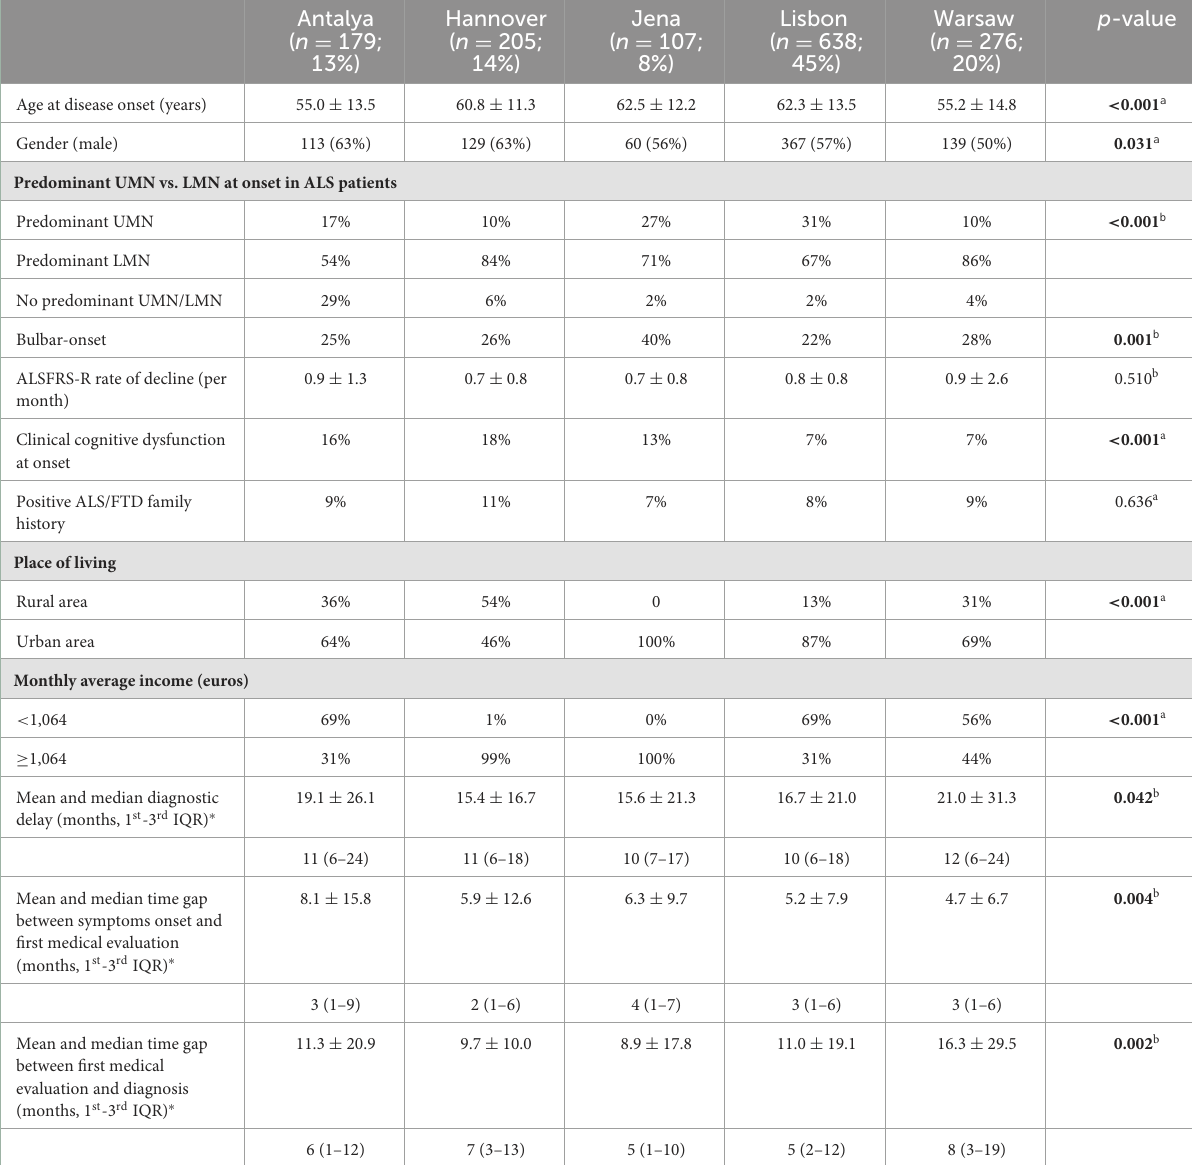
TABLE 1 Baseline characteristics and diagnostic features of ALS patients from each European center.